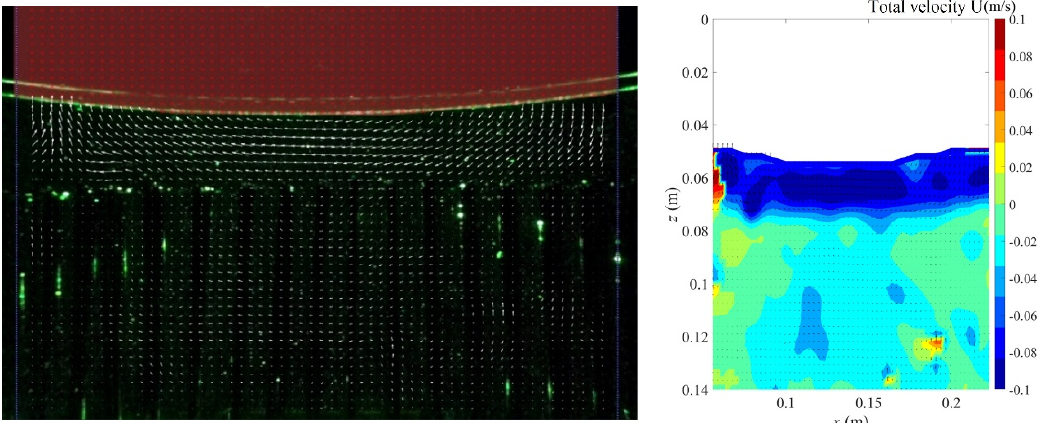
Figure 10. Velocity field and distribution of a short-period wave crest ( T = 0.5 s) passing through vegetation structures ( ϕ = 0.2 cm and d = 10 cm).